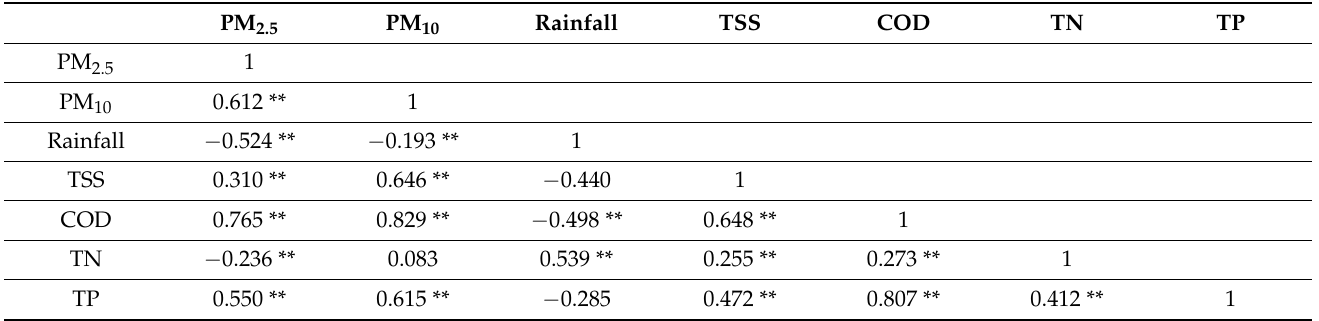
Table 5. Correlation analysis of inflow water quality parameters with rainfall and air pollution.